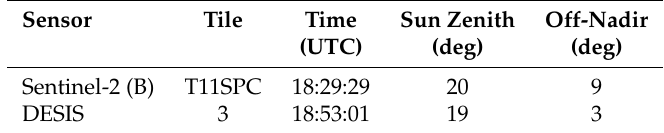
Sensor Tile Time Sun